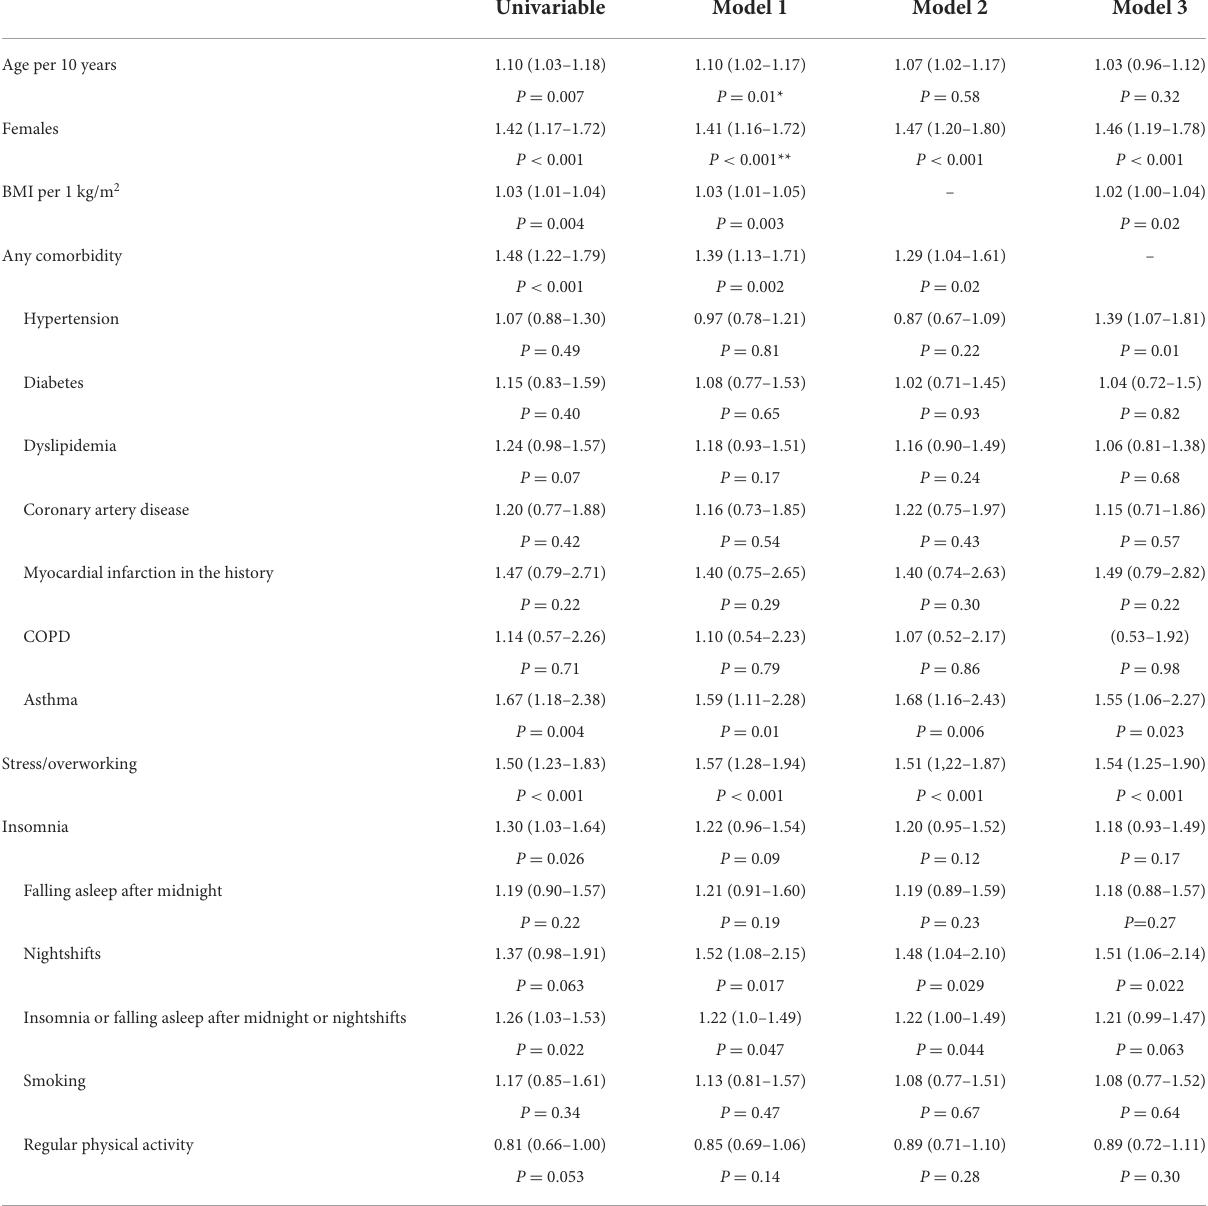
TABLE 2 Multivariate analysis of predictors for a moderate or severe COVID-19 clinical